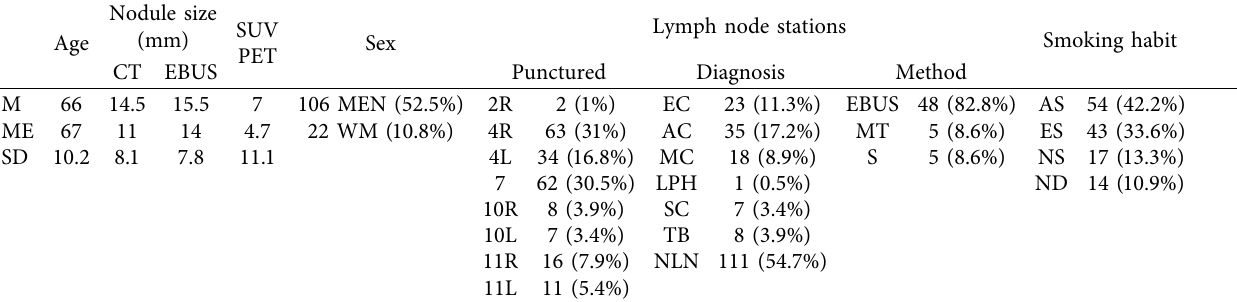
Table 1: Description of the sample: distribution by age, sex, smoking habit, mean nodule size, and characteristics of punctured lymph node